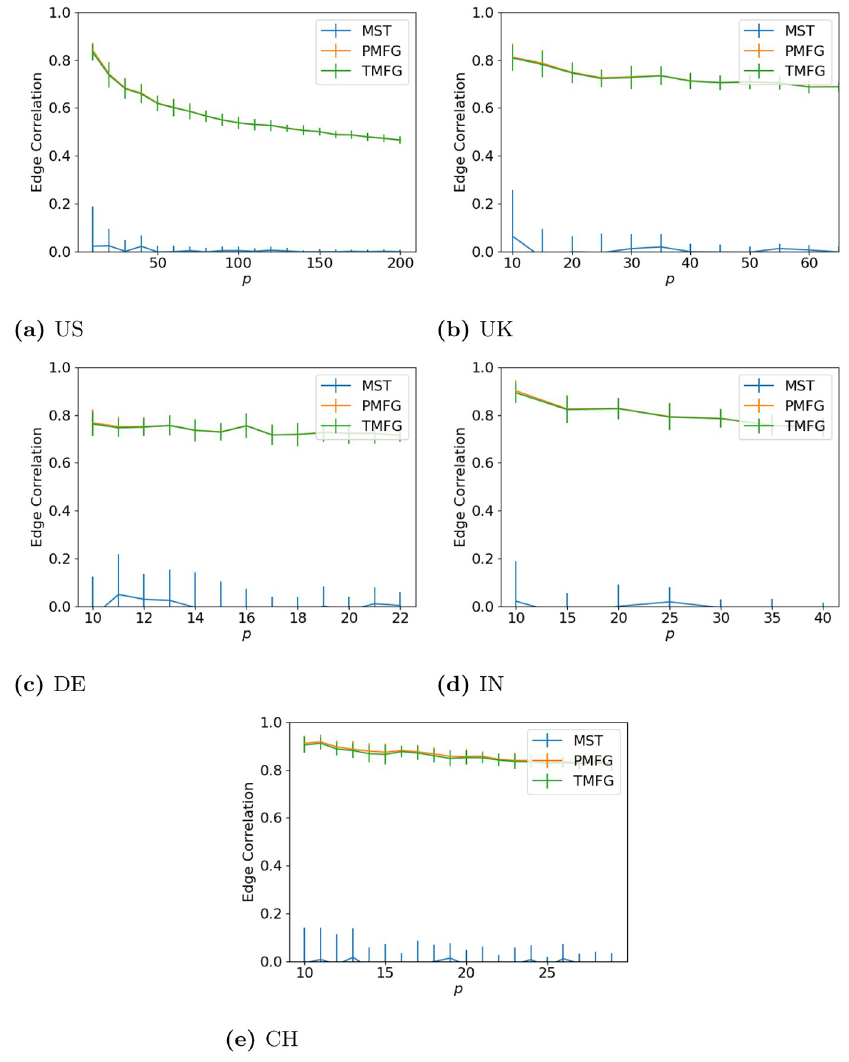
Fig 7. Agreement between edges between the full and filtered correlation matrices with different values of p for the window with median volatility. (a) US, (b) UK, (c) DE, (d) IN, (e) CH.